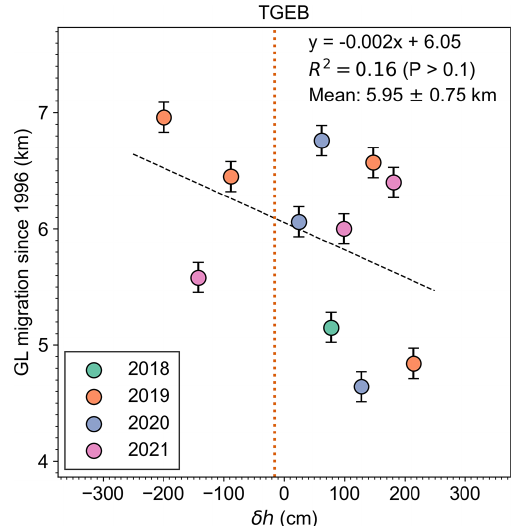
Figure 7. Comparison between the grounding line (GL) migration and differential tidal predictions δh from the CATS2008 tidal model (Padman et al., 2002), at acquisition dates of each DInSAR inter- ferogram at Totten Glacier East Branch (TGEB). Positive GL mi- gration values indicate that the GL retreated inland with respect to the reference point, which is the intersection between the 1996 DInSAR-derived GL (Rignot et al., 2011, 2016) and the ice flowline in Fig. 6a. The vertical orange dotted line denotes the differential tidal predication calculated from the CATS2008 tidal model at the time of the satellite passes used in MEaSUREs 1996 ERS-1/2 DIn- SAR GL measurement (Rignot et al., 2011, 2016) (Table S2). The geolocation of tidal prediction reference point is shown in Fig.